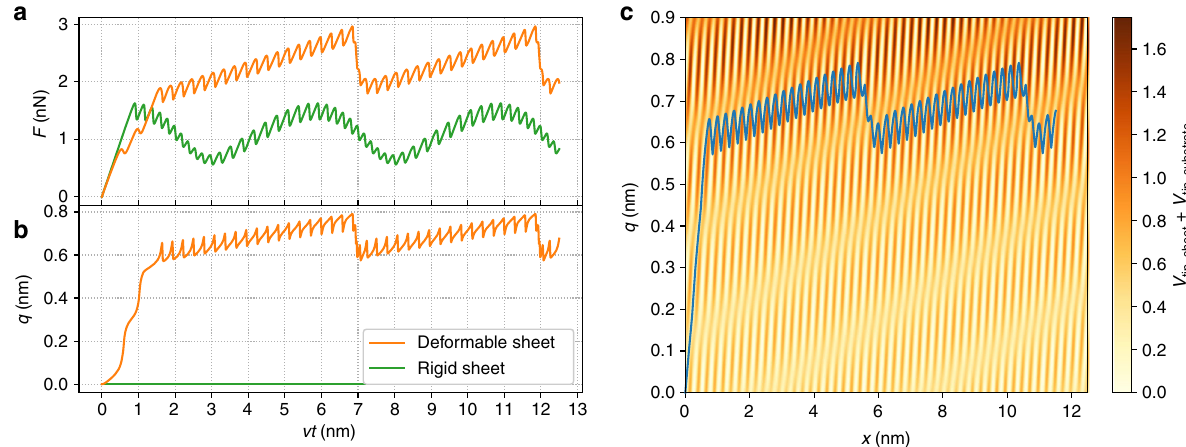
scales linearly with the 4 4 fall on top of each 4